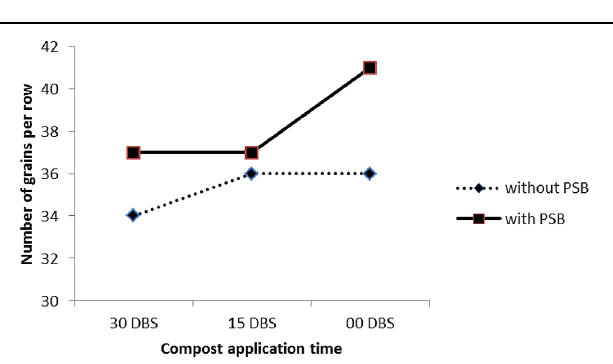
FIGURE 6 | Response of number of grains per row of maize ( Zea mays L.) to phosphorus levels (P) and phosphate solubilizing bacteria (PSB) interaction (P × PSB).